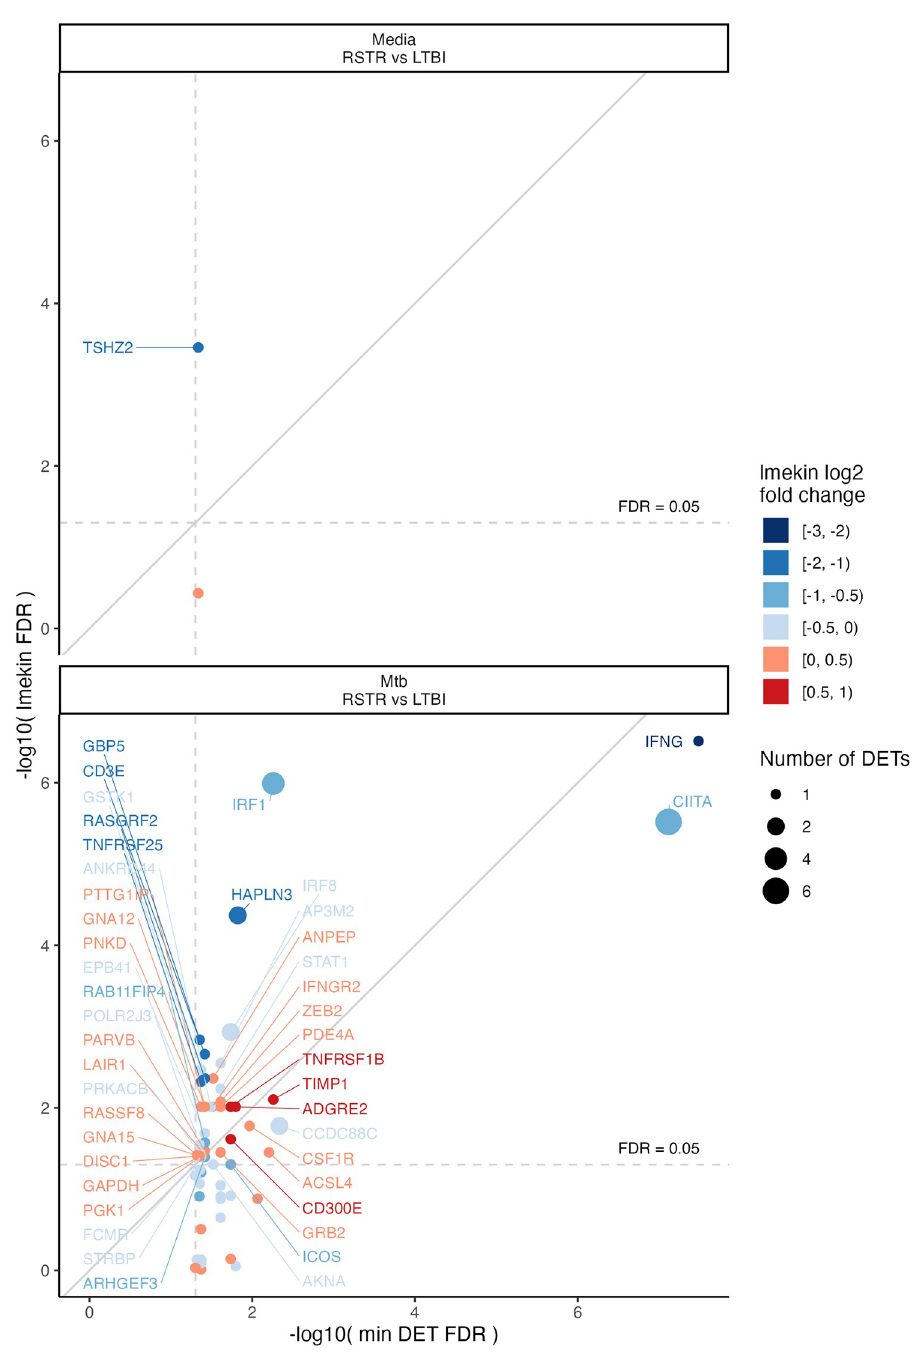
Fig 4. Secondary analysis of genes with � 1 DET indicates the majority remain kinship-adjusted DEGs. Genes with � 1 DET (FDR < 0.05; 65 from Mtb and 2 from media condition) were analyzed by lmekin in the media (top) and Mtb- stimulated (bottom) conditions to confirm which RSTR—LTBI differentially expressed genes (DEGs) remained significant after adjustment for genetic kinship. Correlation plots compare the FDR for RSTR—LTBI expression at the gene-level (lmekin model, y-axis) and transcript level (DET with lowest Sleuth model FDR, x-axis). Node size indicates the number of DETs (FDR < 0.05), and color indicates gene-level lmekin log2 fold change in expression.